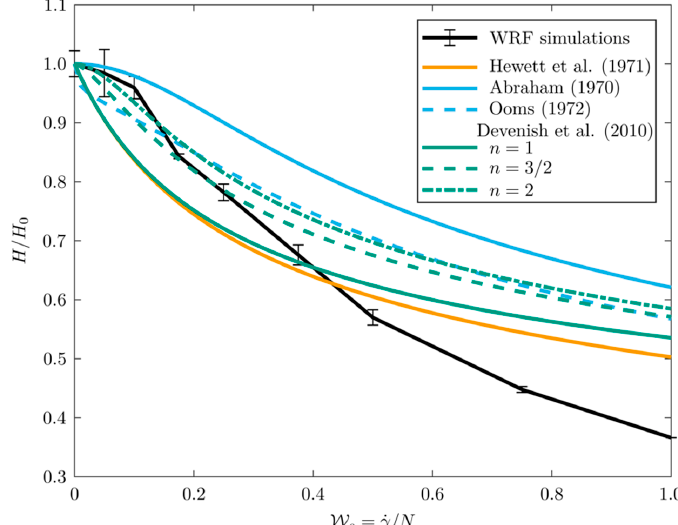
Figure 10. Normalised plume height as a function of the normalised shear W s for WRF results and an integral model adopting di ff erent entrainment parameterizations (see Appendix C and references shown in the legend). Error bars on the WRF results show ±1 standard deviation in the temporally varying height. H 0 is the height in the absence of wind shear. The atmosphere is stably stratified with the Brunt-Väisälä frequency N = 0.01 s − 1 The WRF simulations are also capable of reproducing a further observed feature of wind-blown plumes: the bifurcation of the plume downwind of the vent [58]. In addition, for the weakest plumes in our simulations the plume bifurcates, and consists of buoyant vortex pairs. The bifurcation has been attributed to the development of lateral pressure gradients moving along the margins of the plume [9,58], which should be accompanied by a linear increase in vortex separation with distance. This type of linear separation can be seen in Figure 11a which shows a plan view of the plume, using an iso-surface of concentration used to visualize the plume margin, and it can be seen that the distance from plume axis to plume margin is approximately proportional to downwind distance. We note that in this simulation there are no “clear” regions between the bifurcating branches of the plume—merely substantially lowered concentrations. In Figure 11b, a cross-section through the plume downwind of the vent (at the distance noted on Figure 11a) is shown, with contours of the vertical velocity. The vortical motions can be inferred from the pattern of vertical velocities in Figure 11b. In addition to the central vortex pair, there are further, smaller eddies at the edge of the bifurcated plume. At the ground surface, at a cross-plume distance of 0 km, there is upward motion, flanked by downward motion at approximately 1.5 km AGL. This suggests a separate vortex pair in addition to the vortex pair associated with the stretching and tilting of vorticity near the plume source. Thus, these results show that the motion of the air in the vicinity of the plume is extremely complex.